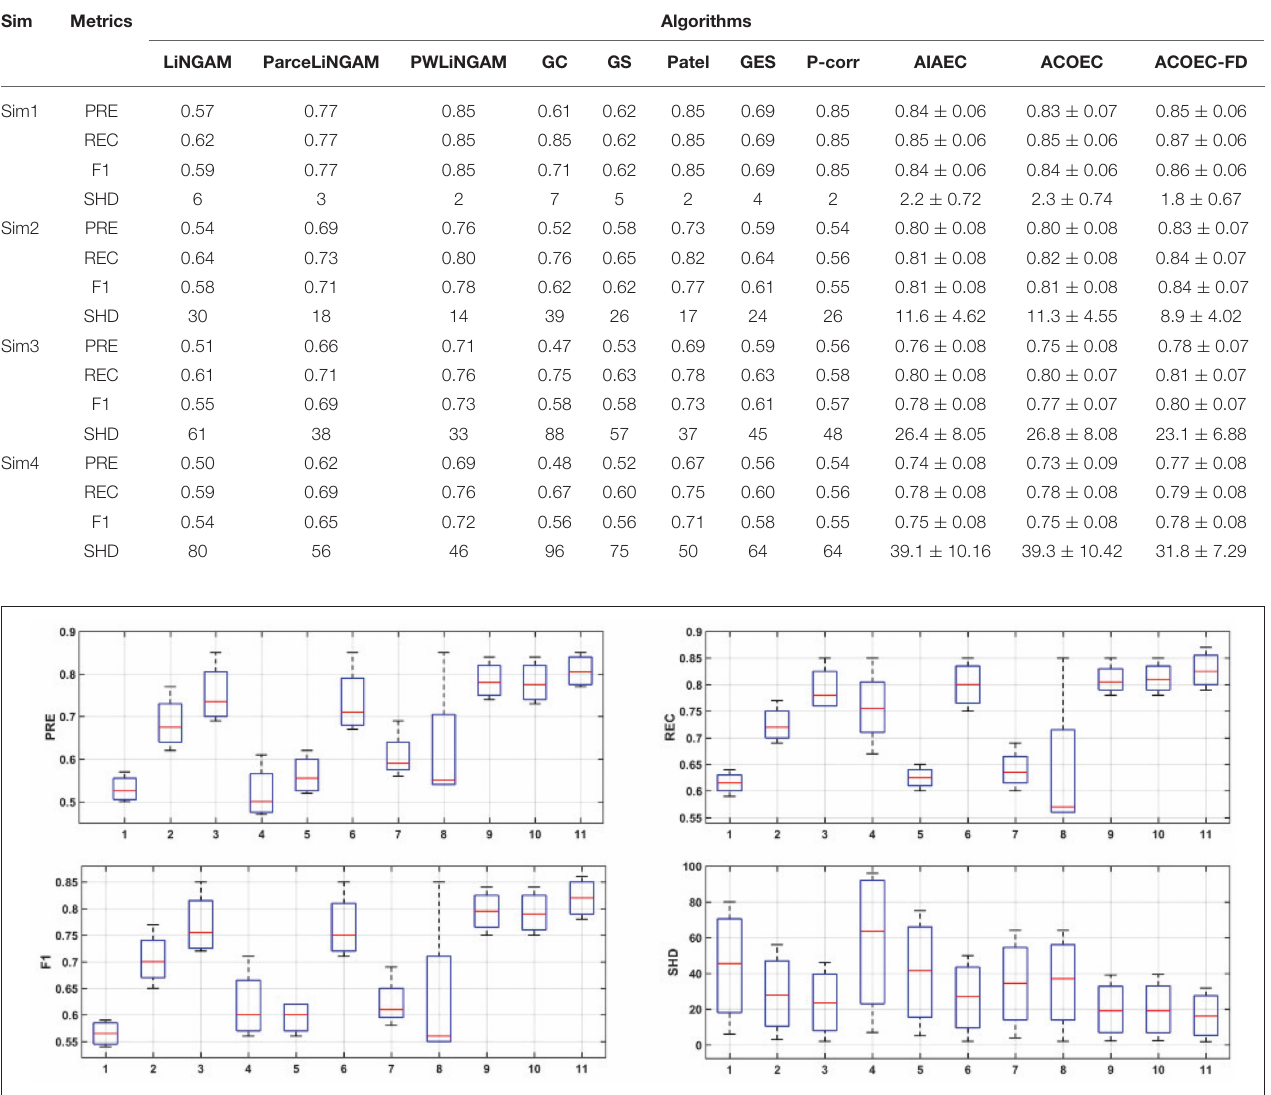
FIGURE 6 | Results for simulation experiments of 11 algorithms. The horizontal axis corresponds to the eleven algorithms, which are LiNGAM (1), ParceLiNGAM (2), PWLiNGAM (3), GC (4), GS (5), Patel (6), GES (7), P-corr (8), AIAEC (9), ACOEC (10), and ACOEC-FD (11), respectively. The vertical axis corresponds to the four